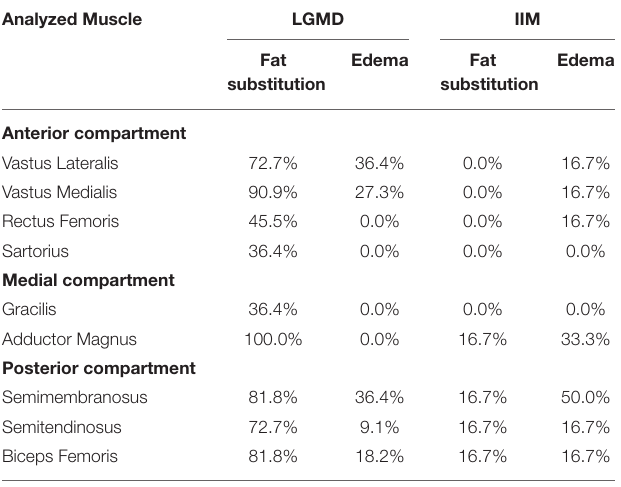
TABLE 1 | The percentage of people with high-grade fat substitution and edema of the thigh muscles among patients with limb-girdle muscular dystrophy and idiopathic inflammatory myopathy.